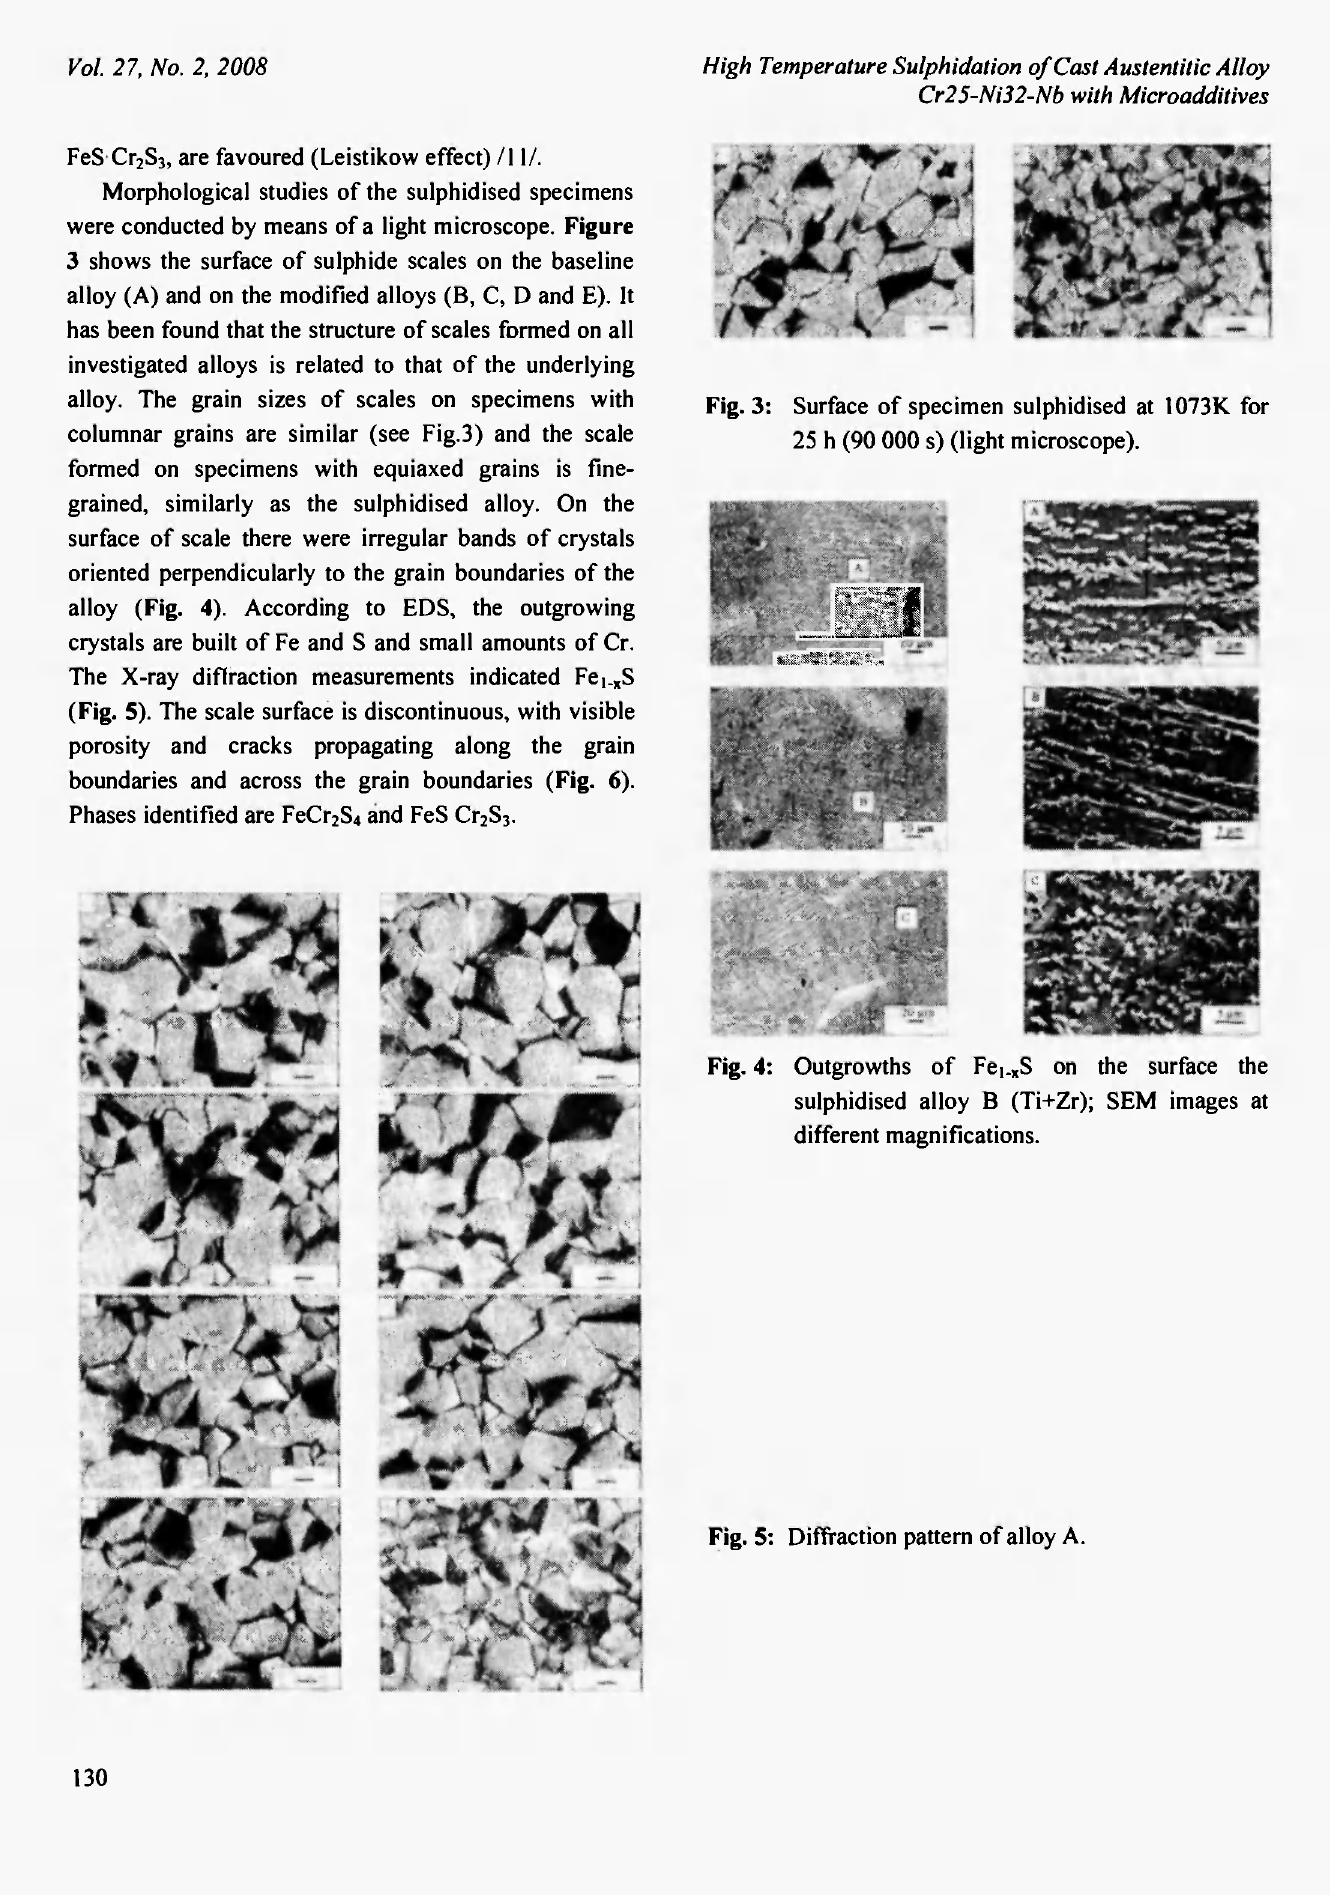
Fig. 5: Diffraction pattern of alloy